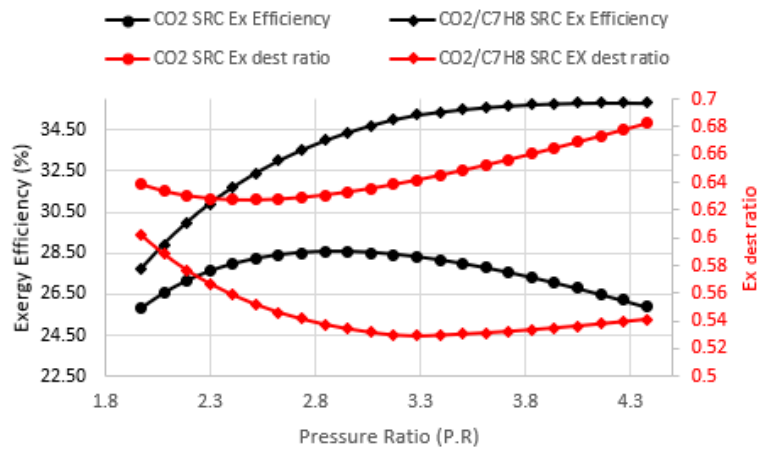
Figure 5. Exergetic efficiency and exergy destruction ratio of CO 2 SRC and 0.9CO 2 /0.1C 7 H 8 SRC with respect to pressure ratio. Energies 2020 , 13 , x FOR PEER REVIEW